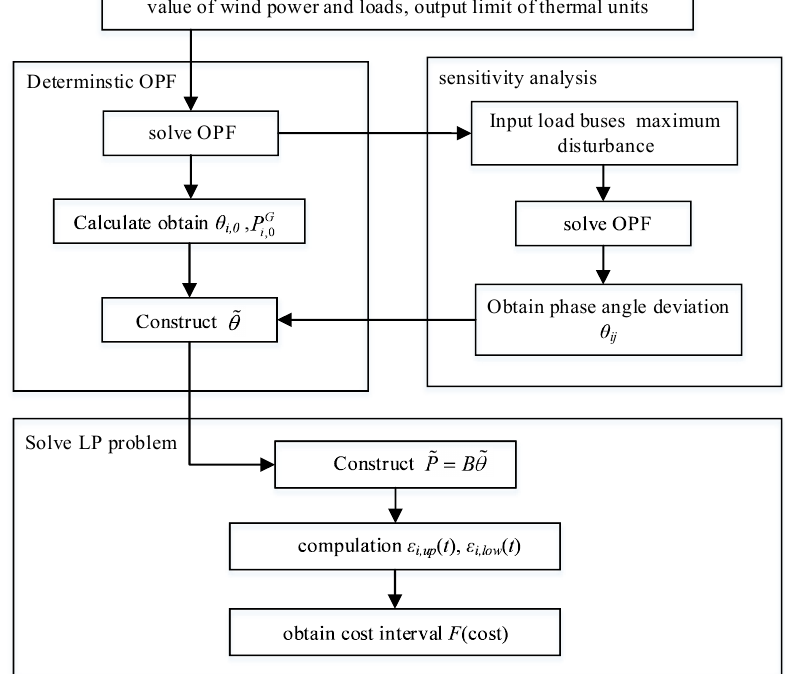
Figure 3. Flowchart for the affine arithmetic-based computation of cost